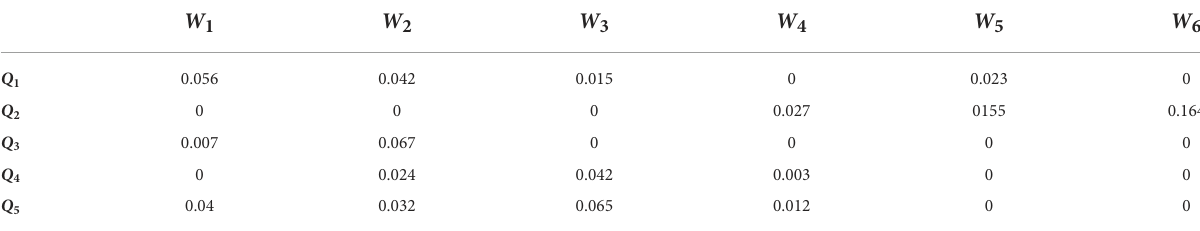
TABLE 15 The NDA matrix.